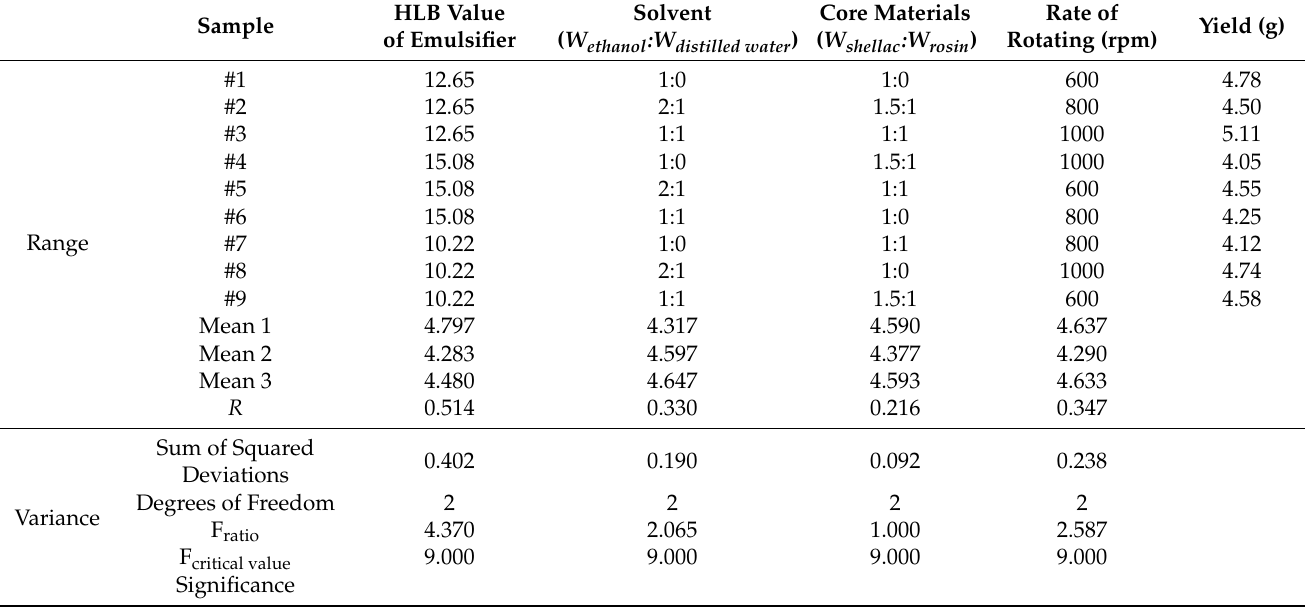
Table 6. Range and variance results of yield of microcapsules.